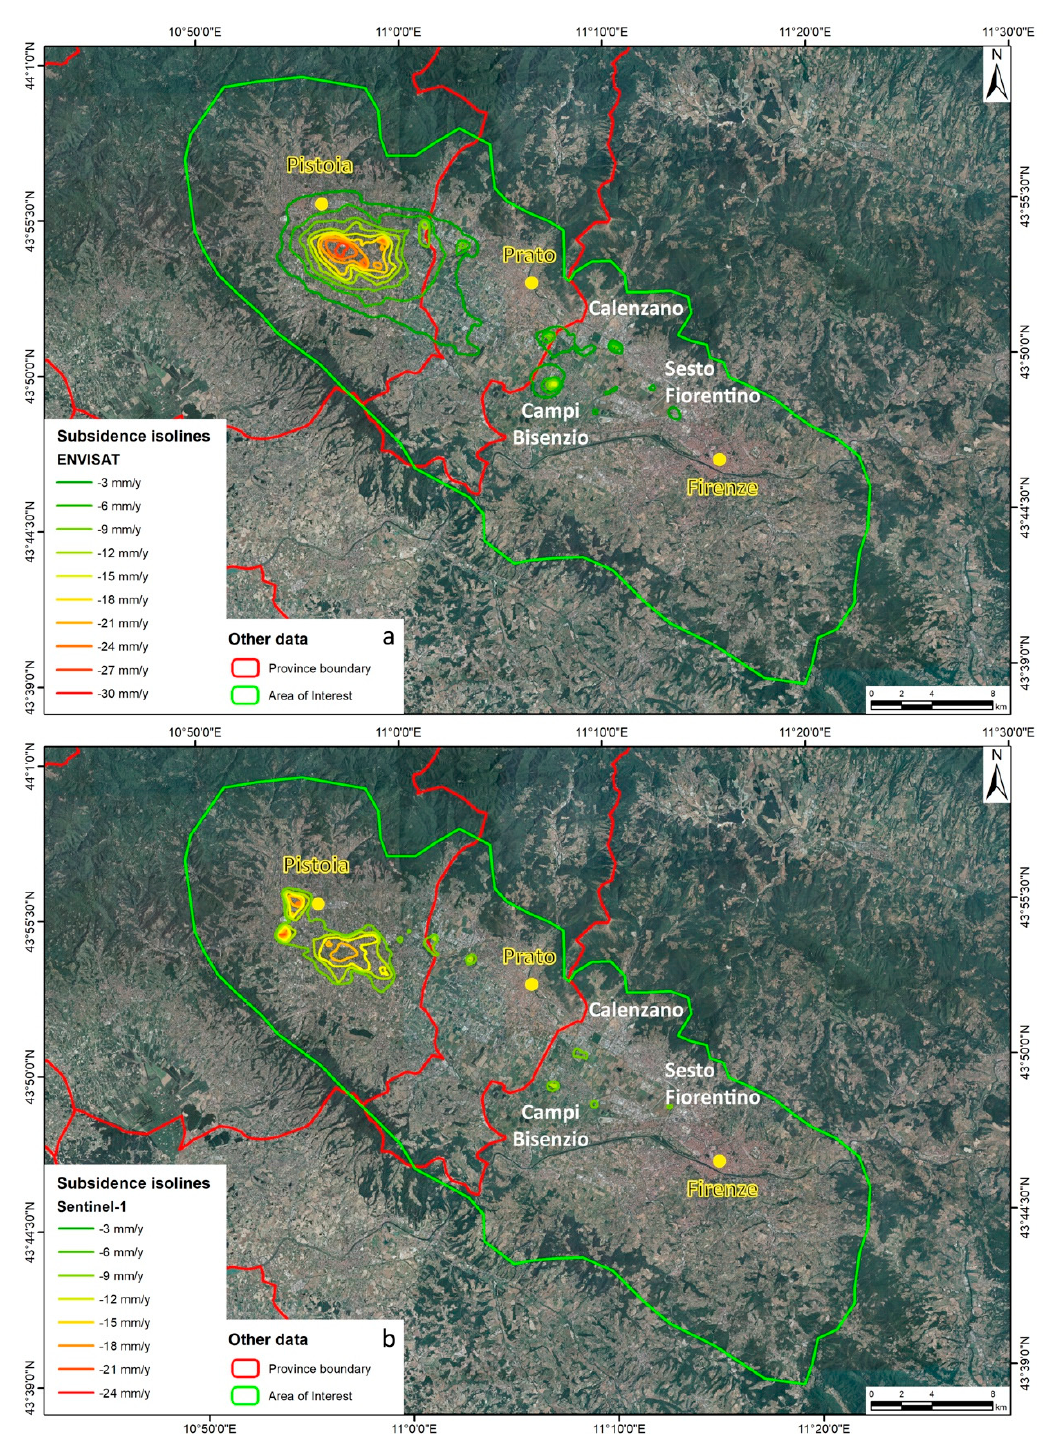
Figure 9. Boundary of the subsidence areas recorded by the ENVISAT (2003–2010, ( a )) and Sentinel-1 (2014–2017, ( b )) constellations. Different subsidence rates between the two monitored periods may be due to changes in groundwater exploitation rates.